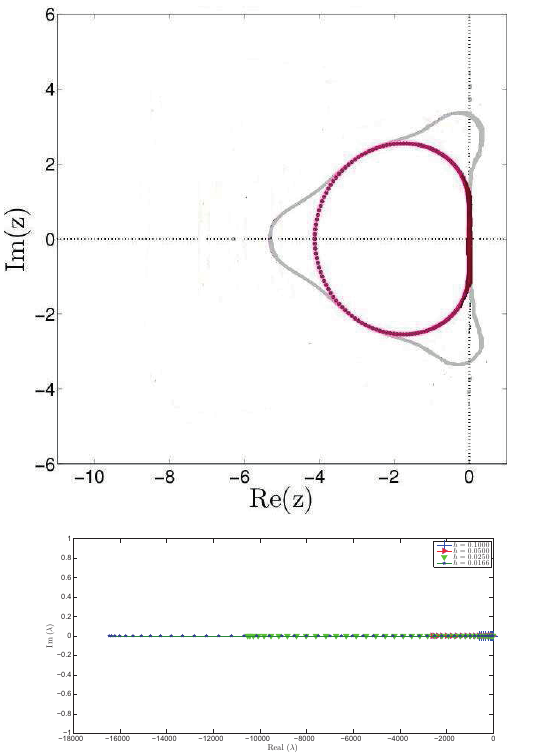
Fig. 1: Stability region for SSP-RK54 algorithm (left) and eigenvalues of B x + B y for different grid sizes h = 0.1, 0.01, 0.025,